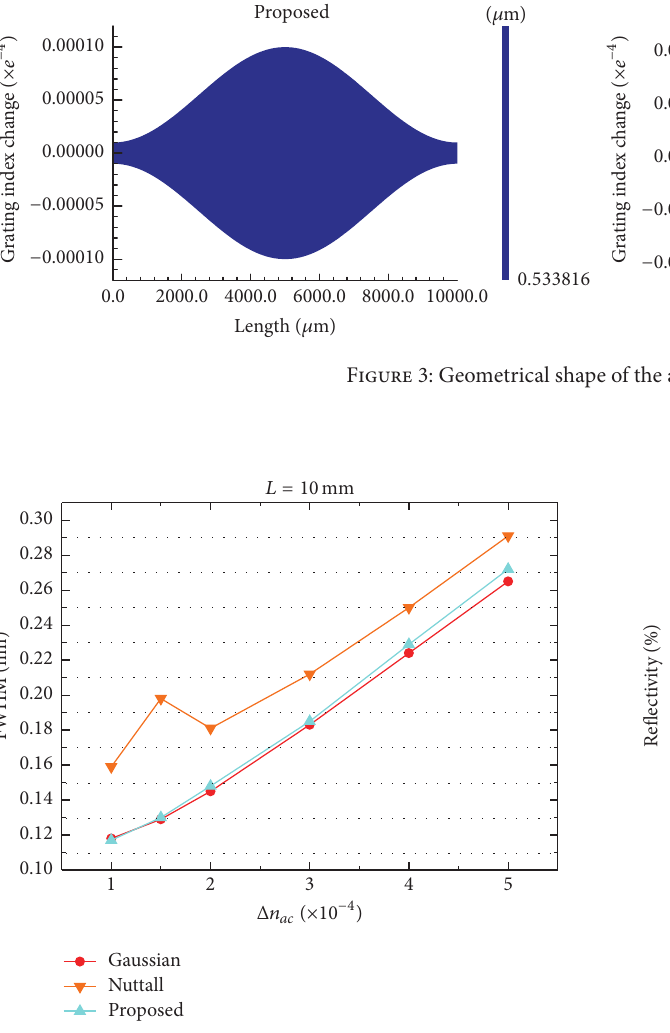
Figure 4: FWHM versus refractive index. Figure 5: Reflectivity versus refractive